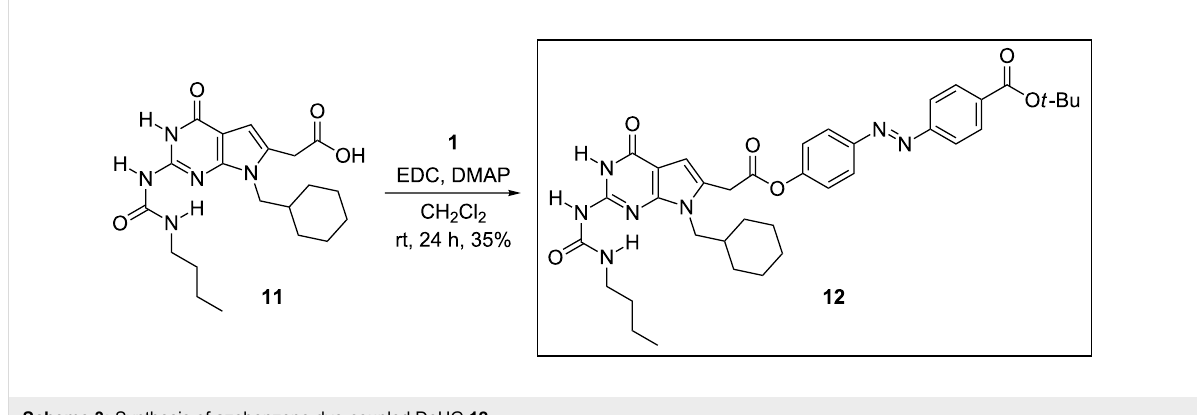
Scheme 3: Synthesis of azobenzene dye-coupled DeUG 12 .